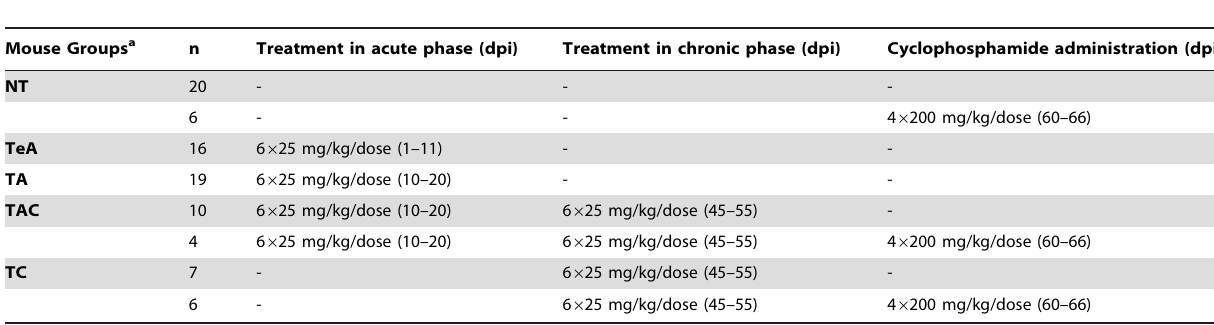
Table 1. Mouse groups and AmBisome treatment schedules.